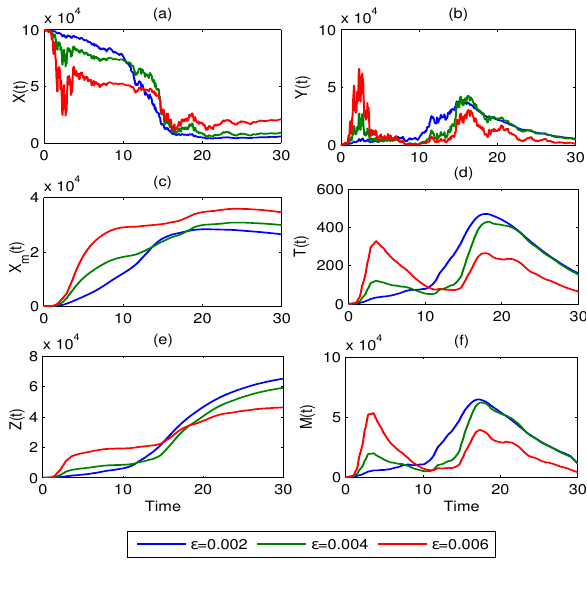
Figure 7. Simulation of solution of each states for different values of per- turbation parameter ǫ .